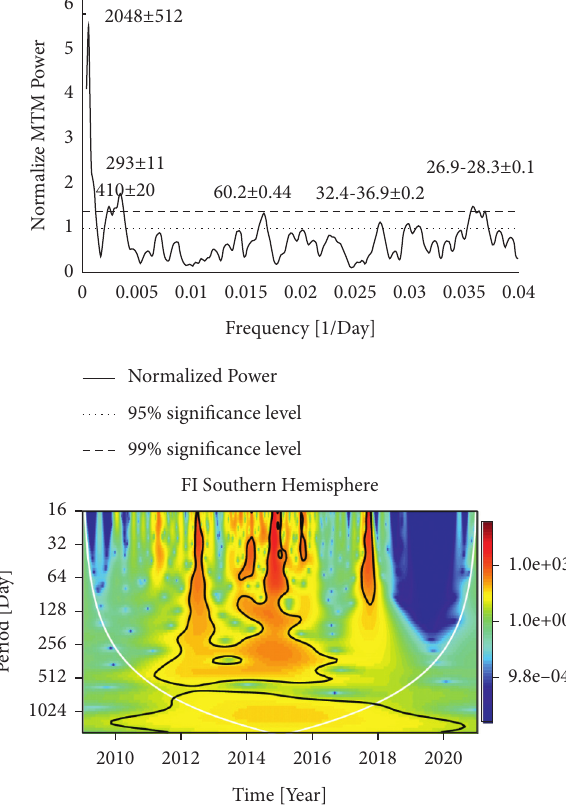
Figure 3: MTM (upper panel) and Morlet wavelet (lower panel) analysis results for Southern Hemisphere FI data for the investi- gated time interval. White solid line in the wavelet scalogram shows the cone of influence (COI); black solid lines show the significant level. In the Morlet wavelet scalogram, the significance of